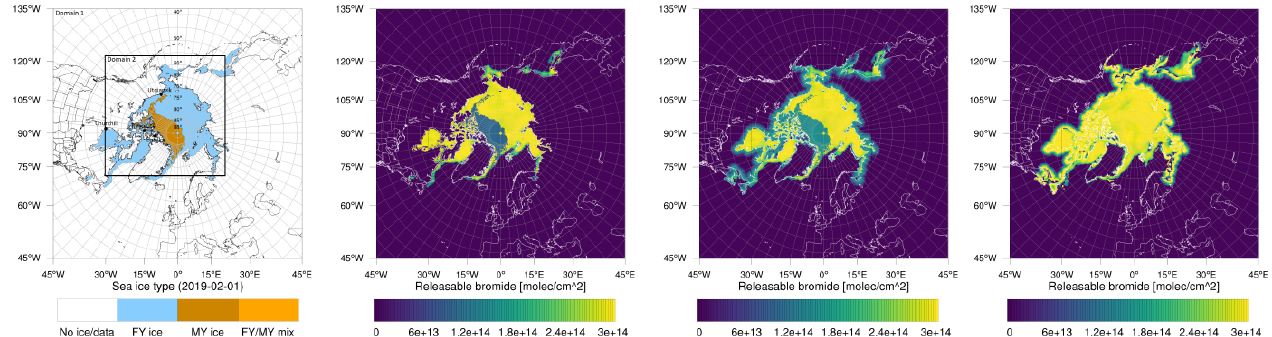
Figure 1. From left to right: sea ice type data (Aaboe et al., 2017) and initial releasable bromide for the low-bromide (left center), medium- bromide (right center), and high-bromide (right)